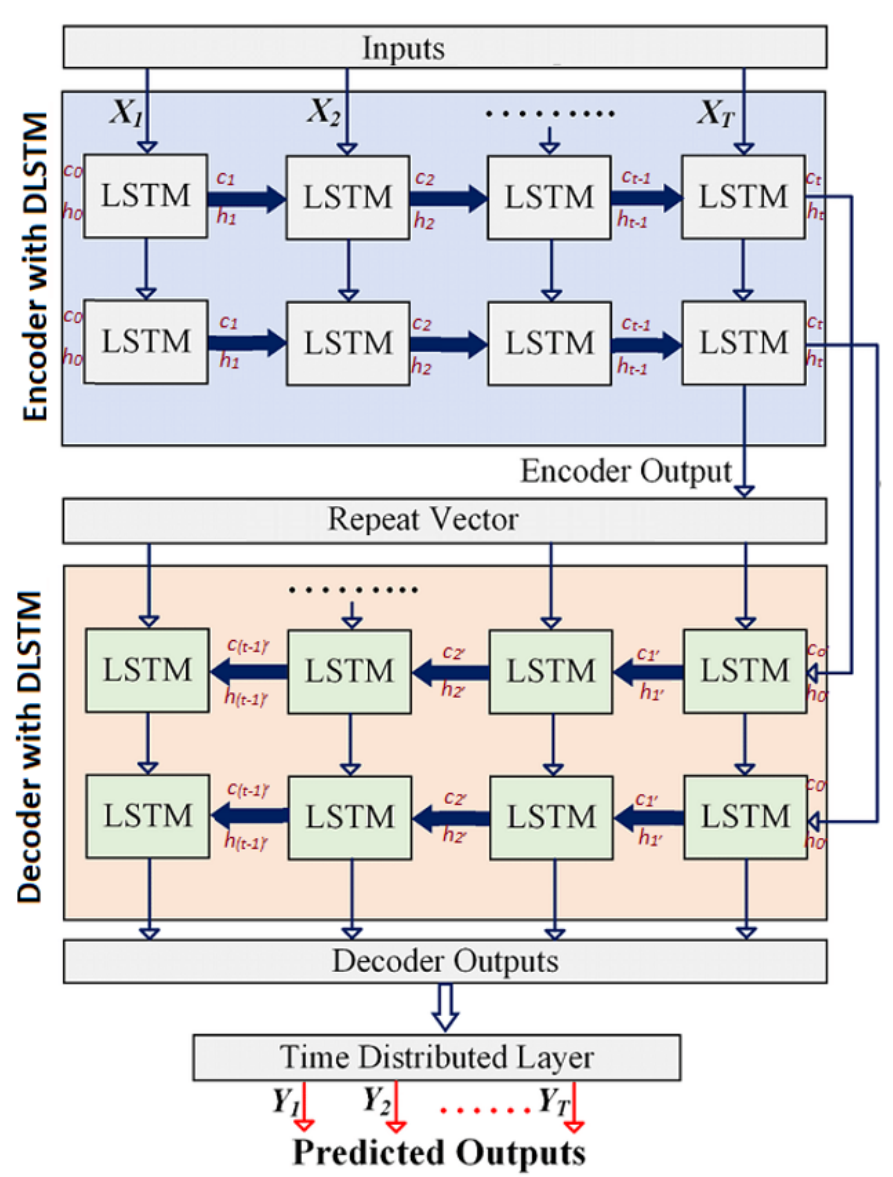
Figure 5. The stacked LSTM sequence-to-sequence autoencoder (i.e., SAELSTM) architecture used to predict GSR at six solar energy farms in Queensland, Australia. Note: Detailed description of the notations in Section